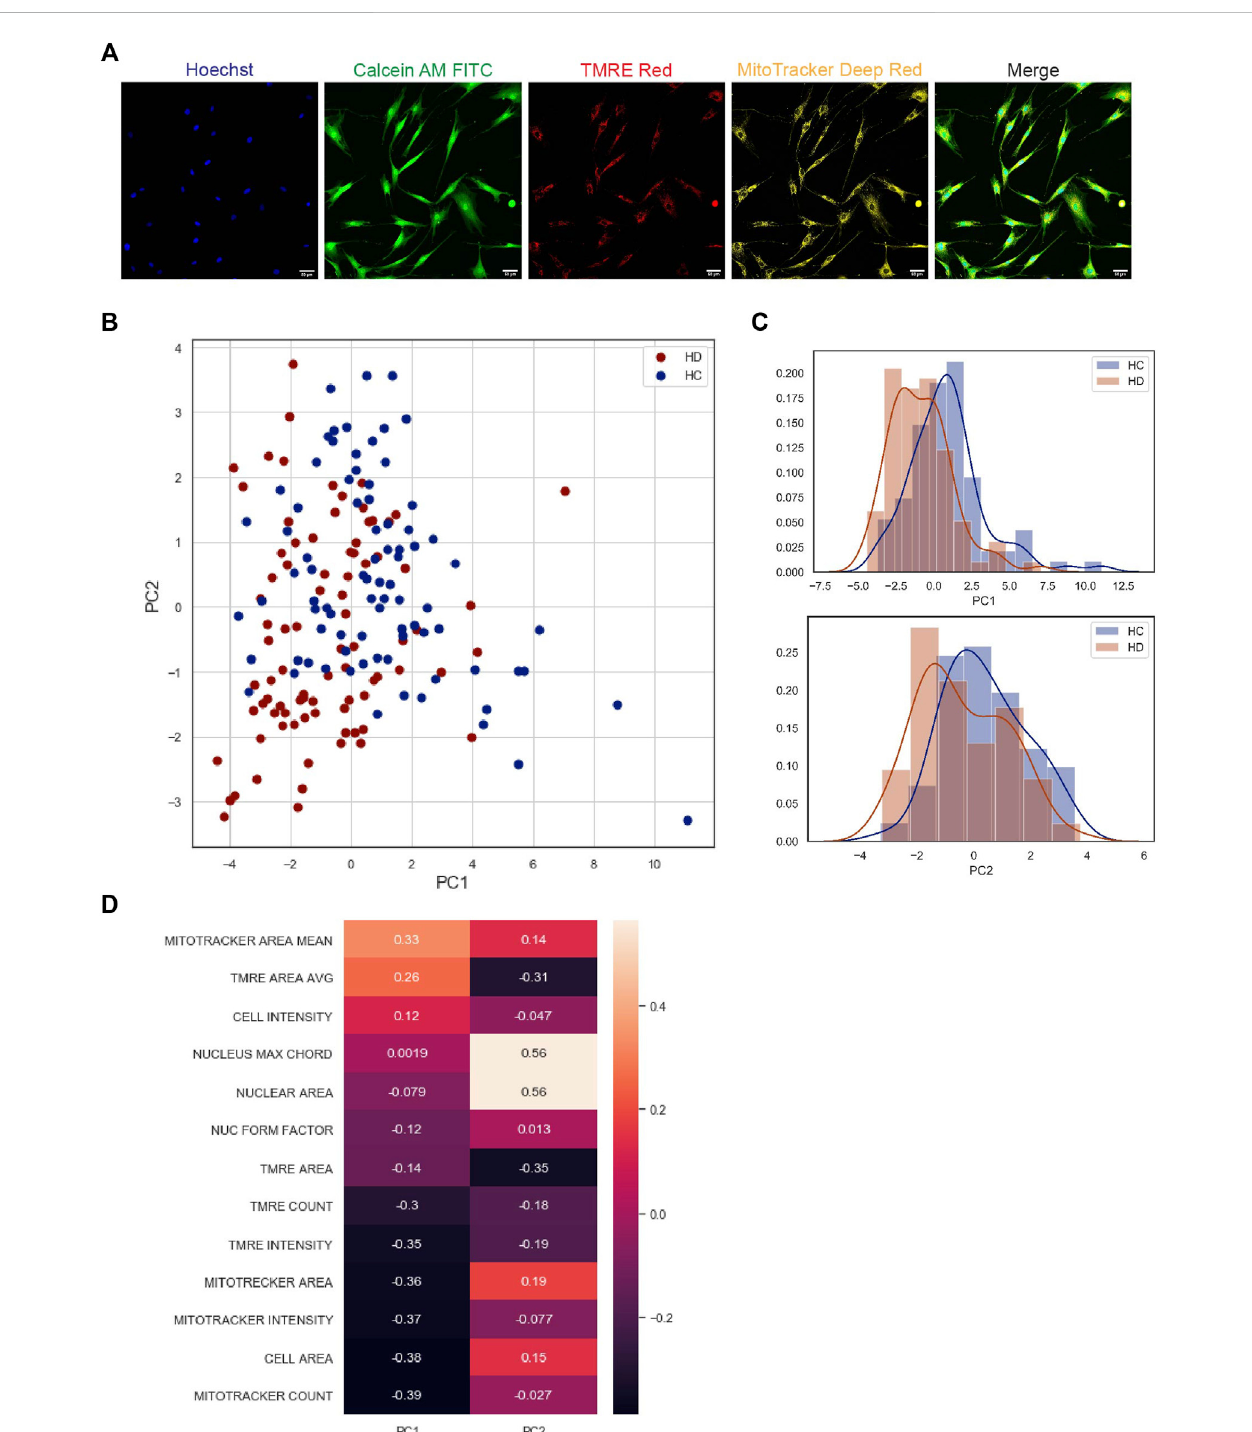
FIGURE 1 High content image based analysis of primary skin fi broblast samples of HD patients compared to HC (A) Representative images of skin fi broblast cells stained with 4 different fl uorescent vital dyes (Hoechst 22,342 to label the cell nuclei, Calcein AM to label cytoplasm of living cells, TMRE to label functional mitochondria, and Mitotracker far-red to label mitochondria). The images were acquired by 20x magni fi cation using INCell 2200 image analyzer. Scale bar = 50 µm. (B) Principal component analysis of 12HD vs. 11HC phenotypic data (PCA graph on the right) The analysis shows a separation between the two groups.Eachsampleisrepresentedby6circleseachcircleisthemedianofphenotypicdataextractedfrom20 fi eldscomingfromonewell,each fi eldcontain 10 – 40 cells, blue circles represent HC samples, red circles represent HD samples. (C) (Histogram graphs on the right) represent the distribution of the analyzed PCA data of the two populations in the two dimensions (PC1, PC2), blue histogram represents HC and red histogram represents HD. (D) Plot of featureimportanceinthetwoPCAdimensionsPC1&PC2,organizedfromthemostimportant(orange)totheleastimportantfeature(black)tothesigni fi cant difference between the two populations in the PCA